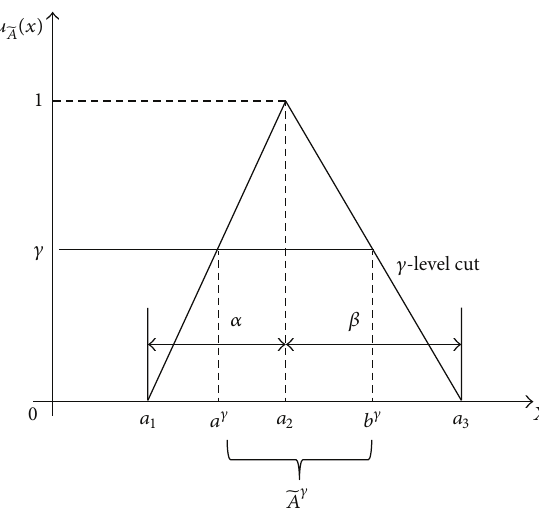
Figure 1: Fuzzy number and 𝛾 -level